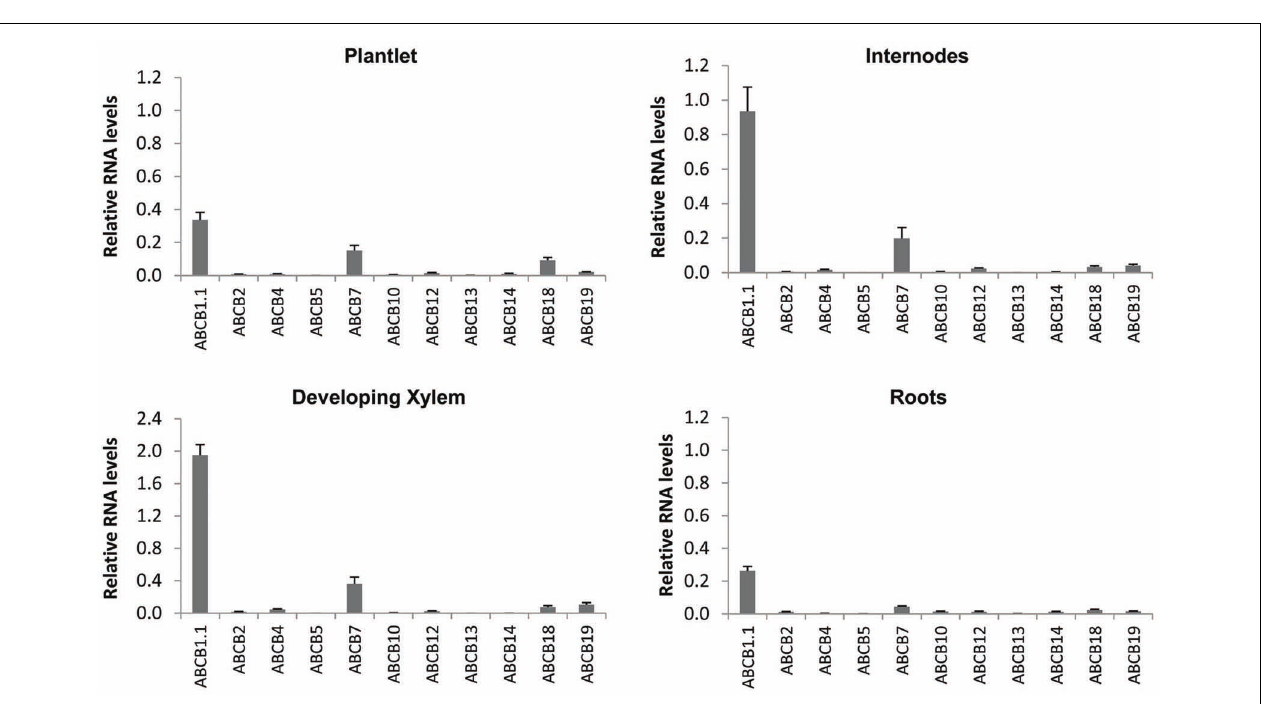
FIGURE 8 | Quantification of ABCB transcripts expression by qRT-PCR. Most notable among the ABCB family is PtaABCB1.1 , which was highly expressed in internodes and developing xylem and whose ortholog in